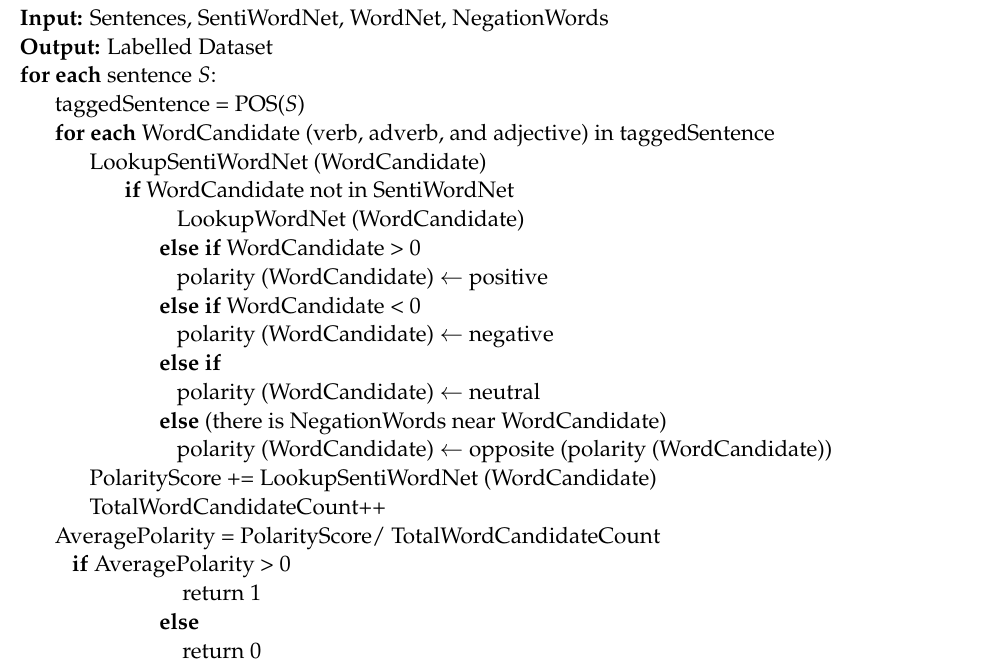
Algorithm 3: Algorithm of the automatic